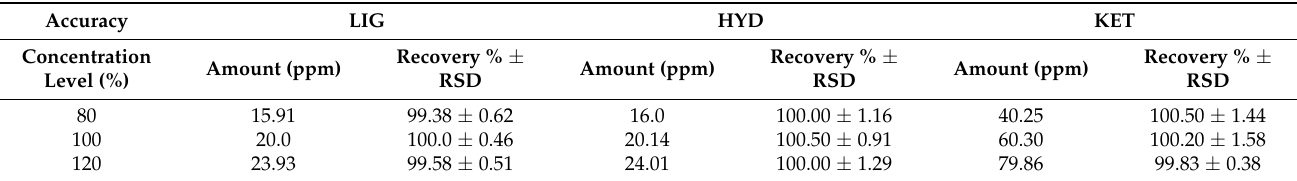
Table 3. Accuracy of the devised method at 80, 100, and 120% analytical